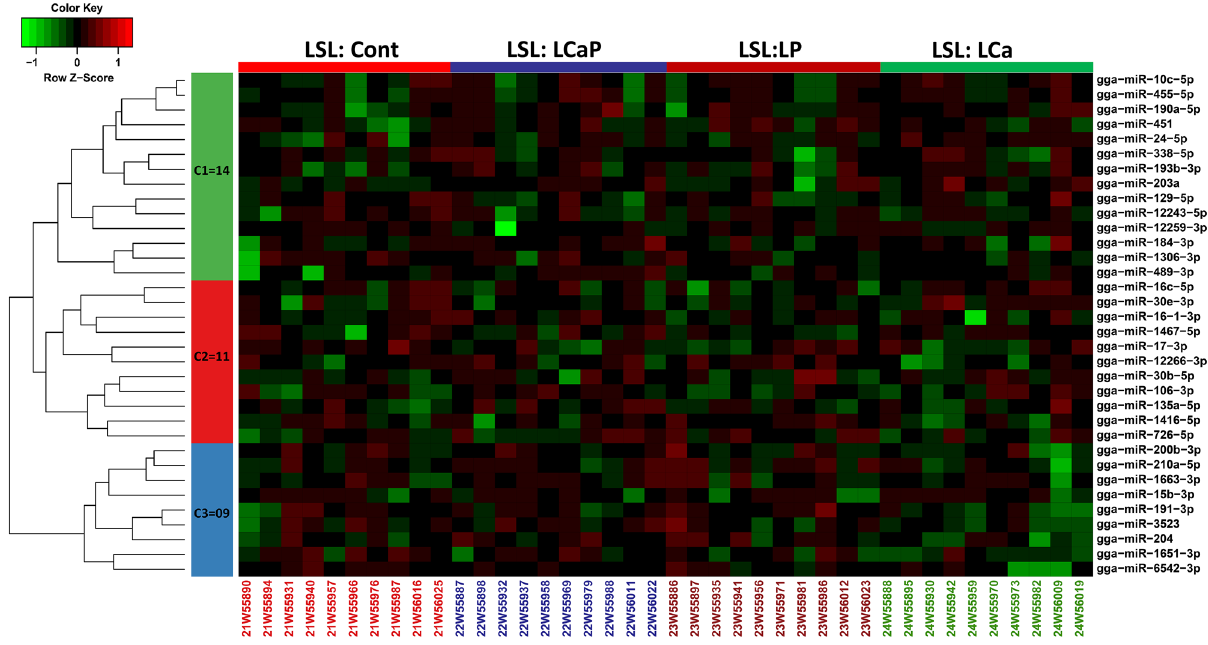
Figure 1. Expression profile of known miRNAs between diet groups within LSL strain. Heatmap of miRNAs expression profiles was generated in the R Programming environment (version 3.4.3) (https:// www.R- proje ct. org/) by using the hierarchical clustering method of heatmap.2 function of gPlots (version 3.0.1) (https:// CRAN.R- proje ct. org/ packa ge= gplots). MiRNAs were assigned to three clusters based on their co-expression with cut-off criteria of variance-stabilizing transformations ≥ 2, |logFC ≥ 1|. A total of 34 differentially expressed known miRNAs were distributed in three clusters including 14, 11 and 9 miRNAs in cluster one, two and three respectively. In color key: green color represents downregulation, red color represents upregulation and black color represents no change in